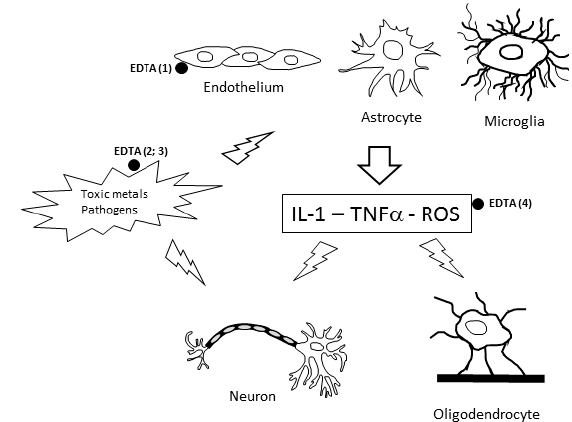
Figure 1. The proposed mechanisms underlying the efficacy of ethylenediaminetetraacetic acid (EDTA) chelation therapy against neurotoxicity. Toxic agents, (toxic metals, organophosphorus pesticides (OP), pathogens, air pollution, some drugs) can damage neurons and/or glial cells and endothelial cells directly ( · ). Activated glial cells and endothelium produce reactive oxygen species (ROS) and pro-inflammatory cytokines (IL-1, TNF α ), which are able to further damage neurons. Treatment with EDTA ( • ) has the following effects: (1) Protection against endothelial activation; (2) removal of toxic metals; (3) possible anti-inflammatory functions (limiting pathogen infections and cytokine production); and (4) antioxidant activity (reducing ROS levels).